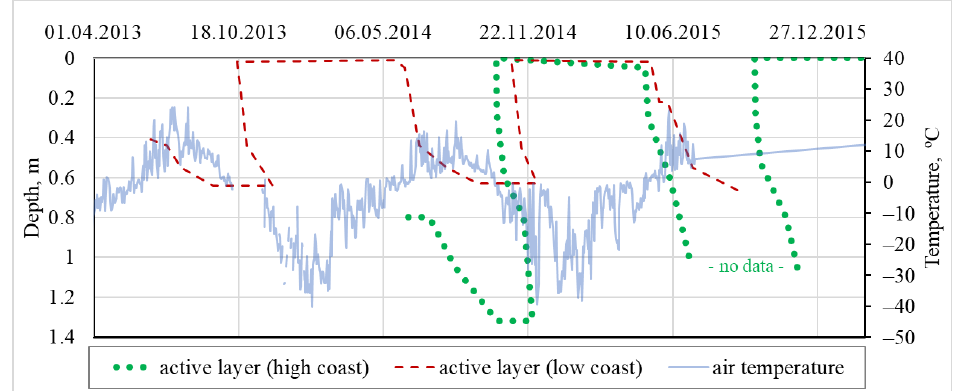
Figure 8. Changes of active layer thickness at the boreholes: MSU #4 and #6.